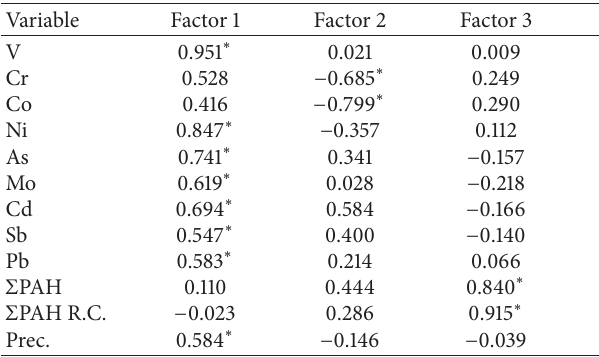
Table 3: Factor coordinates of the variables, based on correlation, of the first three factors obtained by PCA analysis of fluxes collected in D4, D5, and D6 from September 2006 to March